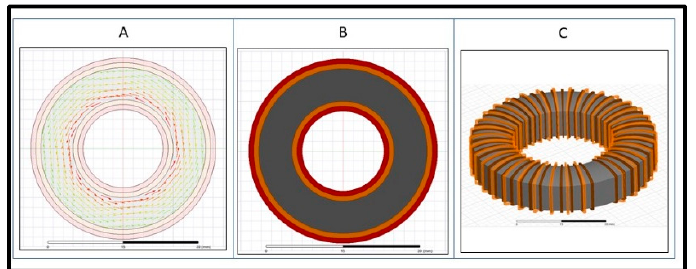
Figure 7. The 360° conventional ( A ) 2D model; ( B ) flux distribution; ( C ) 3D model.